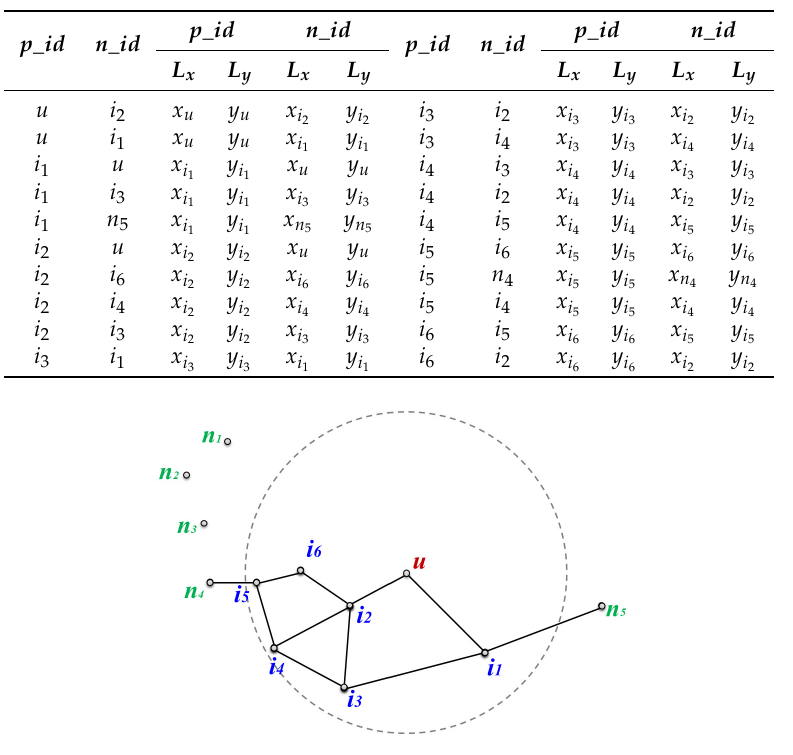
Figure 7. Local full Gabriel graph (GG) within radio range of node u